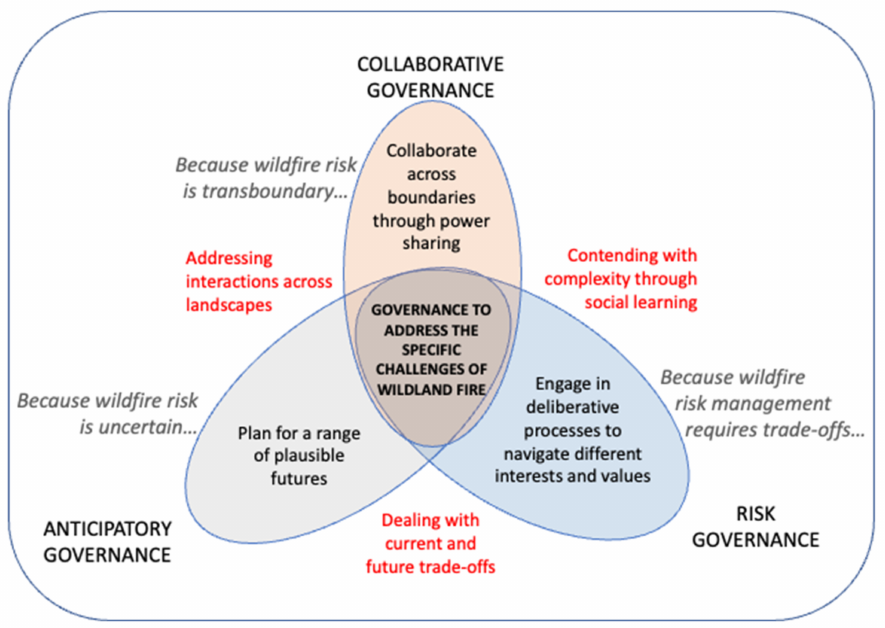
Figure 1. Designing Wildfire Governance to Address Specific